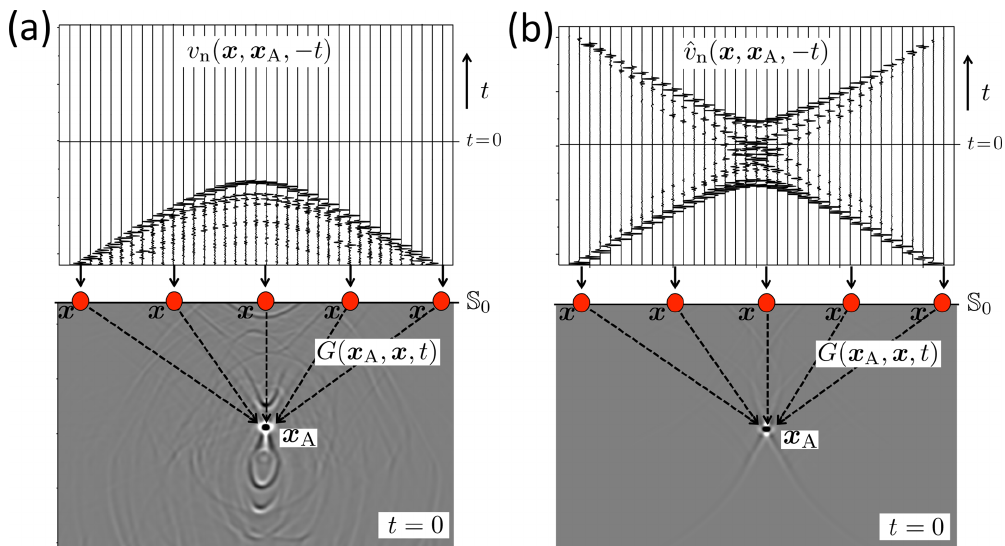
Figure 10. Time-reversal acoustics in a layered medium. (a) Classical approach: emission of the time-reversed recordings from S 0 into the medium. (b) Emission of a modified field, defined by Eq. (36), into the medium. Note the improved